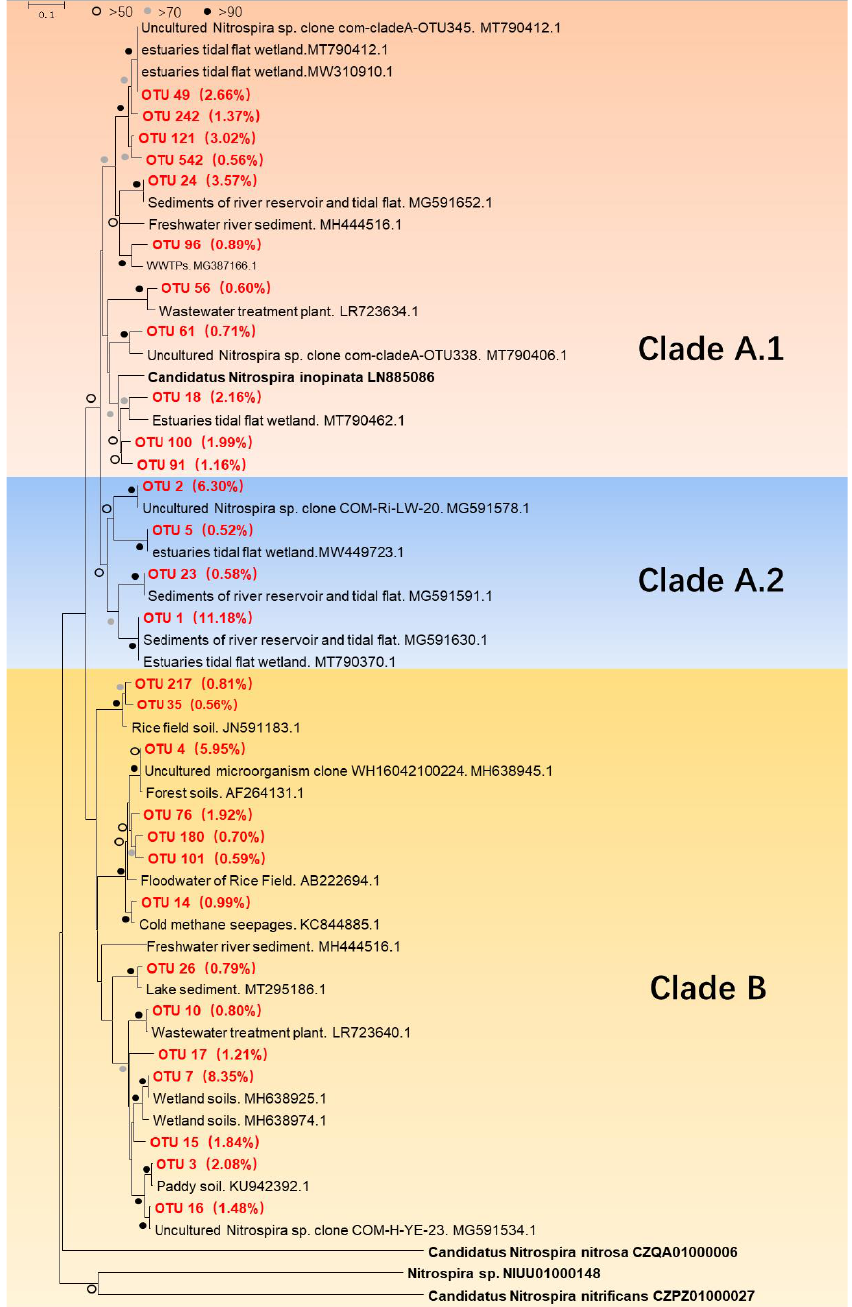
Figure 4. Phylogenetic analysis of comammox amoA genes. The percentage in parentheses (behind OTU) indicates the proportion of each OTU to the total number of comammox amoA genes. Only the obtained OTUs with more than 0.52% comammox amoA gene sequence are displayed in the phylogenetic tree. The reference sequence comes from GenBank. The letters and numbers behind the sequence are the submission serial number. The circle, gray dot, and black dot at the clade nodes represent 50~70%, 70~90%, and 90~100% sequence similarity, respectively. The percentages in parentheses next to the OTUs indicate the proportion of each OTU in the total sequence of comammox amoA genes. The calculation method was the maximum composite likelihood method. The scale bar represents 20% of the sequence